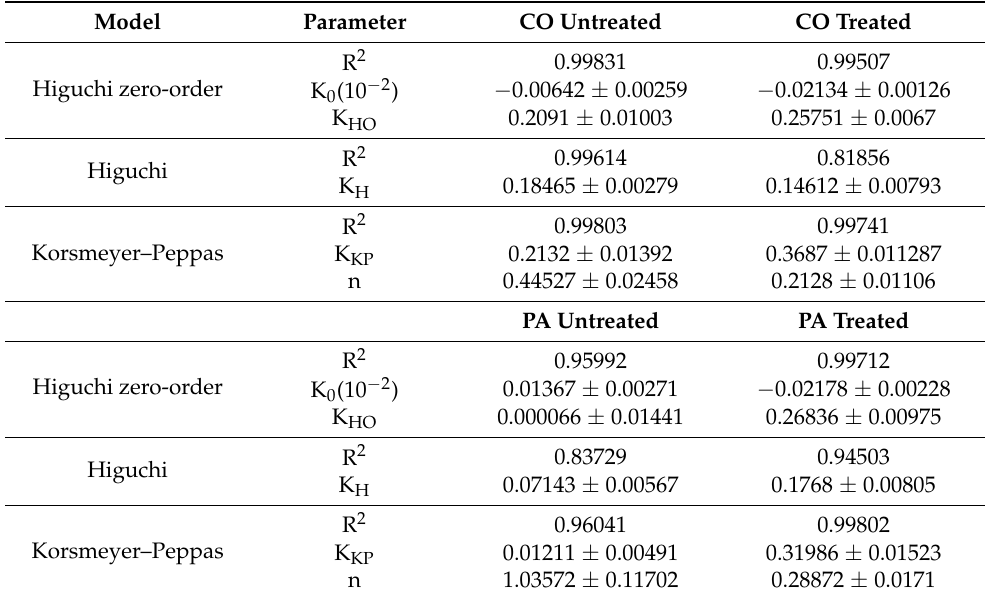
Table 2. Parameters of the mathematical adjustments for the models of Korsmeyer–Peppas, Higuchi and Higuchi